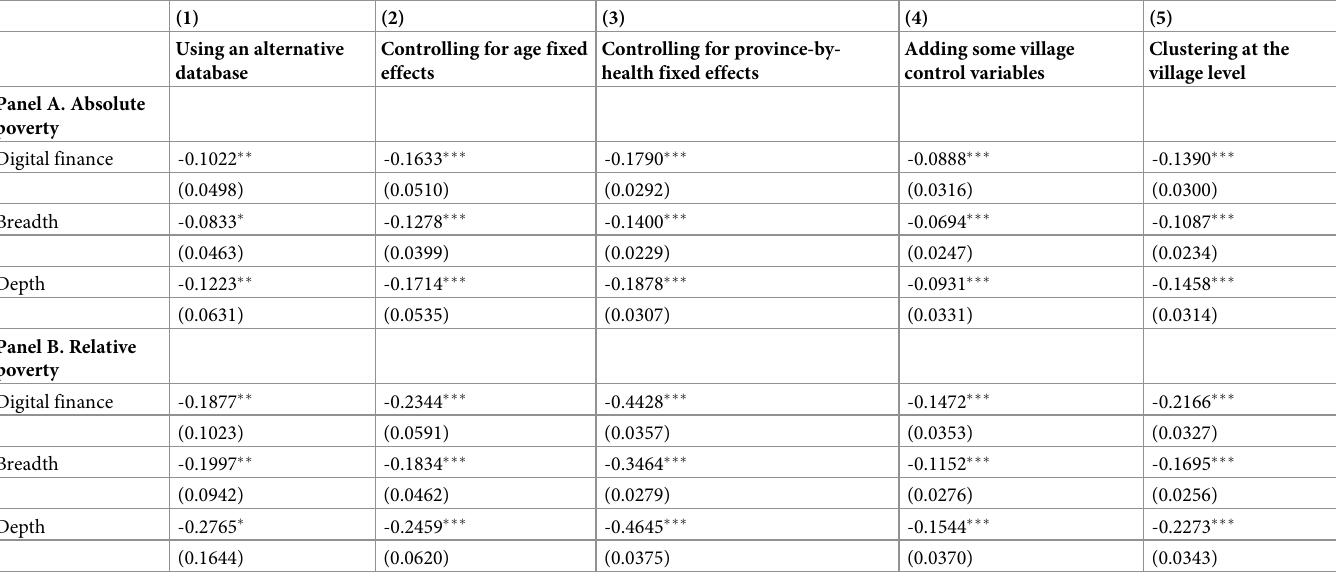
Table 19. Robustness checks by excluding extreme observations or using alternative